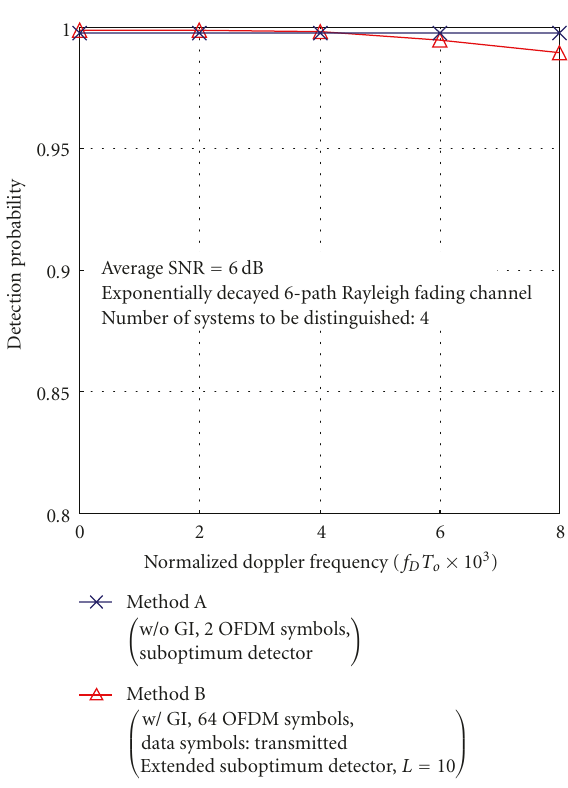
Figure 12: Performance for Methods A and B as a function of Doppler frequency.